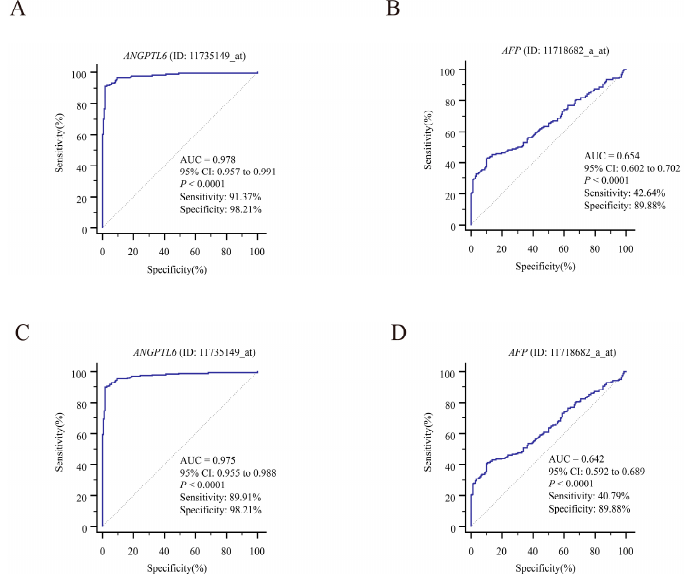
Figure 9. Potential diagnostic values of ANGPTL6 and AFP levels for early-stage and all-stage HCC in the GSE63898 dataset. ( A ) ROC curves for ANGPTL6 to differentiate HCC with early-stage (BCLC 0~A staging) and nontumorous cirrhotic tissues. ( B ) ROC curves for AFP to differentiate early-stage HCC and nontumorous cirrhotic tissues. ( C ) ROC curves for ANGPTL6 to differentiate all-stage HCC and nontumorous cirrhotic tissues. ( D ) ROC curves for AFP to differentiate all-stage HCC and nontumorous cirrhotic tissues. Abbreviations: AFP , alpha-fetoprotein; AUC, area under the ROC curve; CI, confidence interval.